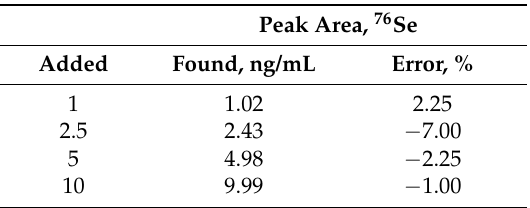
Table 2. Recoveries of selenocysteine (as selenium) added.